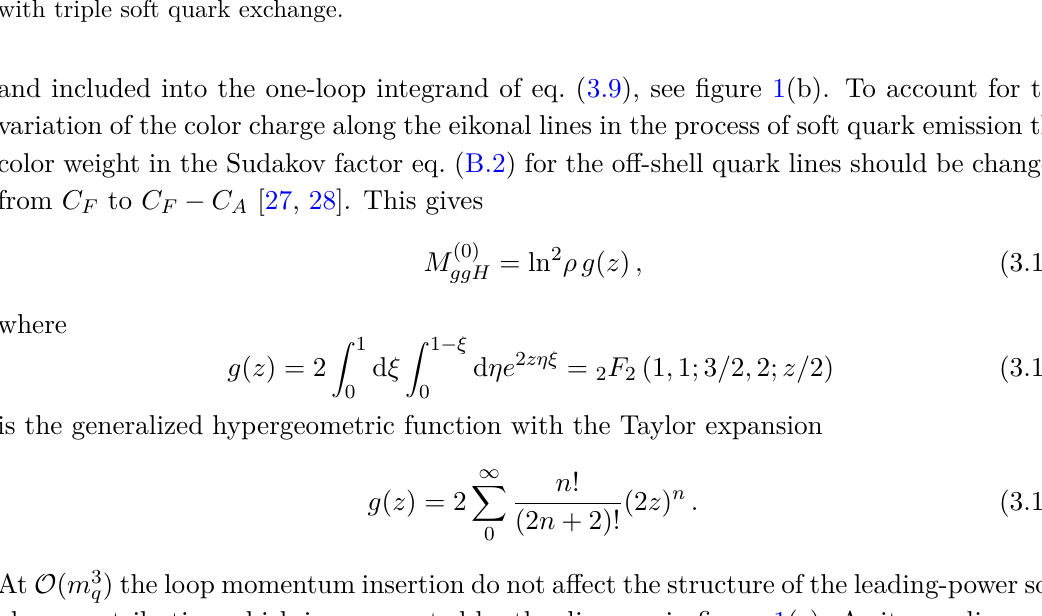
Figure 3 . The three-loop Feynman diagrams for the Higgs boson two-photon decay amplitude with triple soft quark